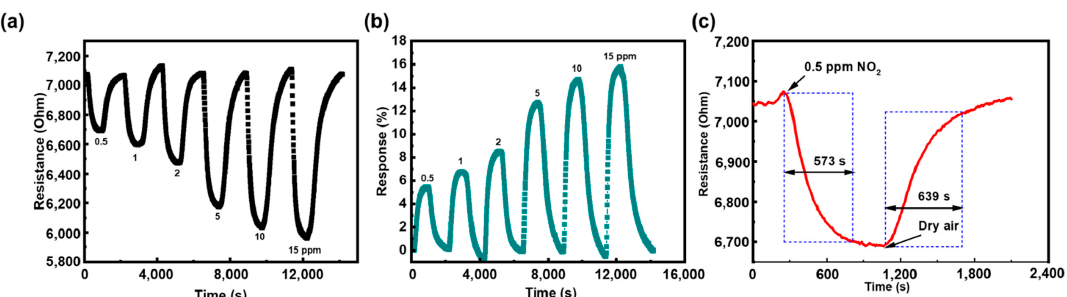
Figure 4. Response of rGO film (dip coating) in 0.5–15 ppm NO 2 . ( a ) Real-time sensing response curve, ( b ) Real-time resistance change curve of rGO film prepared by dip coating from 0.5–15 ppm NO 2 with dry air ( c ) Real-time resistance change curve of rGO film prepared by dip coating in 0.5 ppm NO 2 with dry